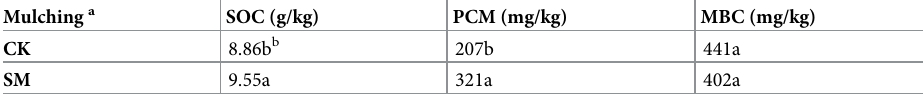
Table 1. Soil carbon fractions before incubation.